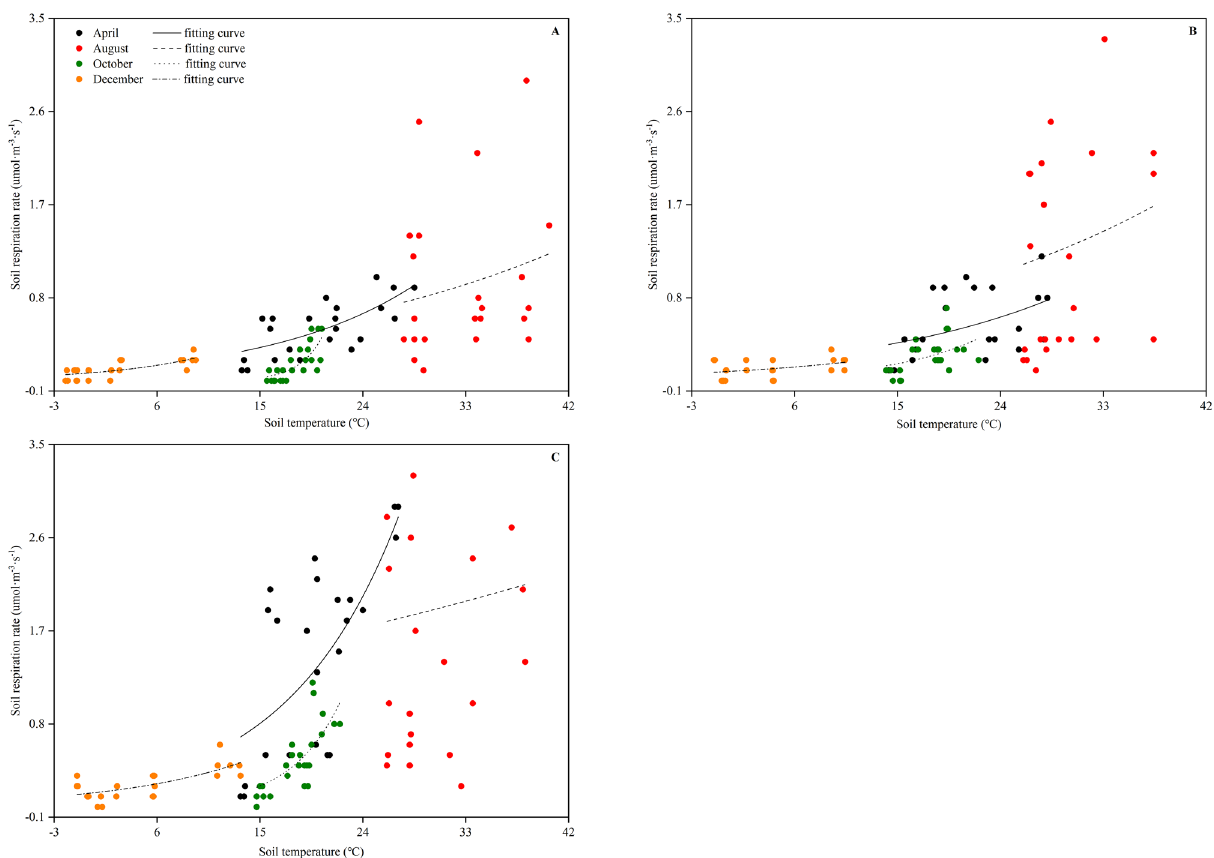
Figure 3. Relationships of the daytime soil respiration in April, August, October and December to the soil temperature at the CK (A) , CT (B) and WM (C) sites. Different types of lines are the nonlinear fits for different months. CK, natural coastal wetland; CT, cotton mono-cropping farmland; and WM, wheat–maize rotation cropping a significant negative relationship ( p < 0.05) to the soil water content at a soil depth of 10 cm (Fig. 4). At the CK site, the soil temperatures in April, October, and December accounted for 47, 61 and 56% of the variation in the RS, respectively (Table 2). At the CT site, the soil temperatures of these three seasons explained 37, 31 and 13% of the variations in the RS, respectively (Table 2). At the WM site, the soil temperature from these three seasons accounted for 34, 58 and 22% of the variation in the RS, respectively (Table 2). An empirical model using both the soil temperature and water content as independent variables was fit to the data set with a simultaneous measurement of the RS, soil temperature and water content to reflect the interactive effect of both factors (Table 2). The combination of the soil temperature and water content at the diurnal scale showed a significant effect ( p < 0.01) on the RS at all three study sites. At the CK site, the combined soil tempera- ture and water content in April, October, and December accounted for 51, 63 and 55% of the variation in the RS, respectively (Table 2). At the CT site, the soil temperature and water content of these three seasons explained 31, 37 and 10% of the variation in the RS, respectively (Table 2). At the WM site, the soil temperature and water content during these three seasons accounted for 41, 55 and 53% of the variation in the RS, respectively (Table 2). Relationship between annual soil respiration and soil temperature and water content. The relationships between the RS of the CK, CT and WM and the soil temperature and water content on an annual scale are provided in Fig. 5 A and B, and the fitted exponent regression equations are shown in Table 3. The RS in the CK, CT and WM showed a significant positive nonlinear relationship to the soil temperature (Fig. 5 A, p < 0.01) and a noticeable positive linear relationship to the soil water content (Fig. 5 B, p < 0.01). At the CK site, the soil temperature and water content accounted for 42 and 47% of the variation in the RS, respectively. At the CT site, the soil temperature and water content accounted for 35 and 22% of the variation in the RS, respectively. At the WM site, the soil temperature and water content accounted for 33 and 6% of the variation in the RS, respectively. The synergic effects of the soil temperature and water content on the RS of the CK, CT and WM were also remarkable, explaining 44, 43 and 41% of the variation in the RS, respectively ( Table 3 ). Relationship between soil respiration and soil physico-chemical properties. The correlation analysis between the RS and soil physico-chemical properties is shown in Fig. 6. RS had a positive relationship to soil total nitrogen, available phosphorus, pH, and soil organic carbon, while the relationship between the